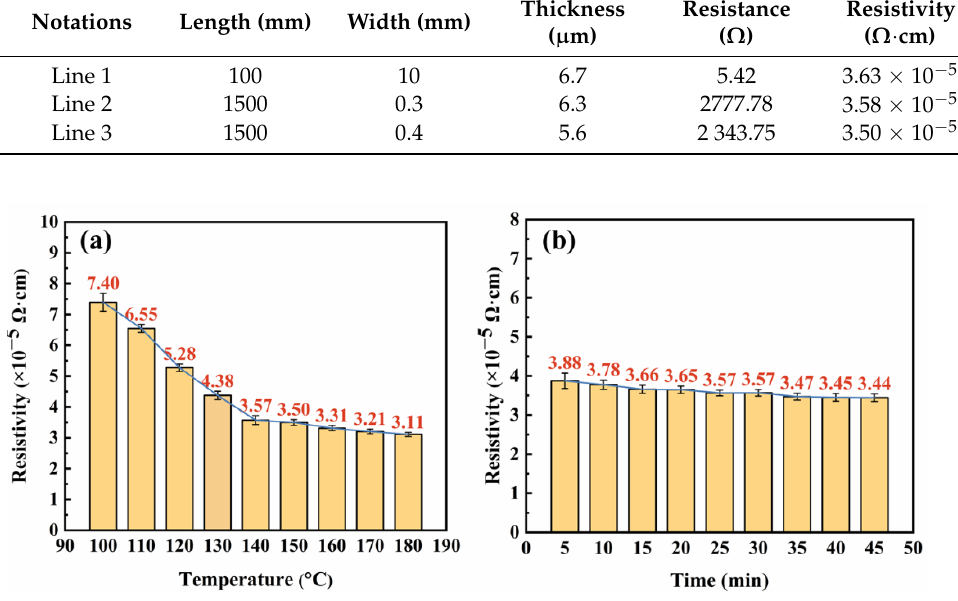
Figure 11. The average resistivity of conductive films: ( a ) Resistivity versus sintering temperature ( b ) Resistivity versus sintering time.